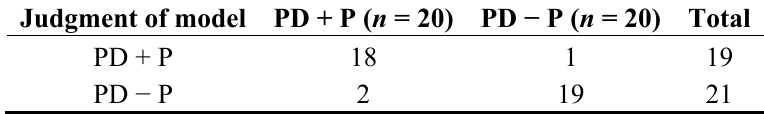
Table 6. Evaluation of the PDE peptidome pattern for the testing. Judgment of